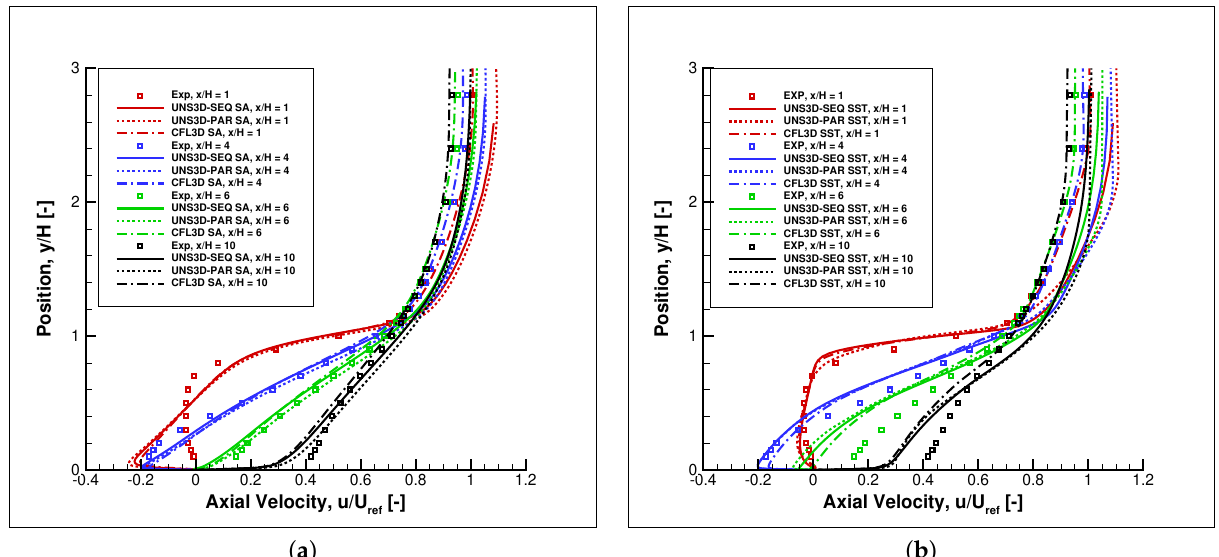
Figure 19. Velocity profiles on backward-facing step: ( a ) Spalart–Allmaras, and ( b ) Shear Stress Transport.